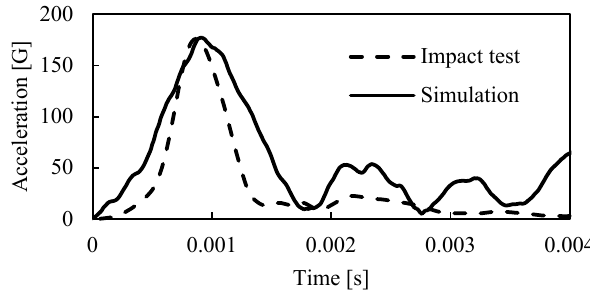
Figure 3. Comparison of the resultant acceleration of the head’s centre of gravity (CoG) when the ball impacts the Hybrid III head with the